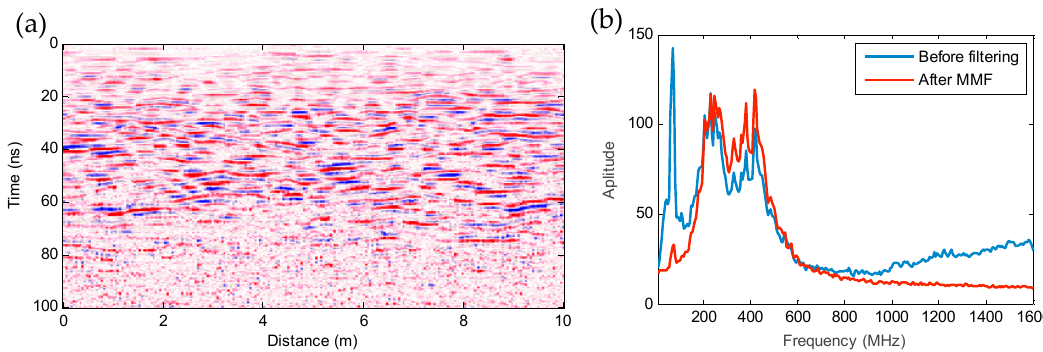
Figure 9. ( a ) The result by morphological filtering; ( b ) the amplitude spectra of the results in Figures 6a and 9a.